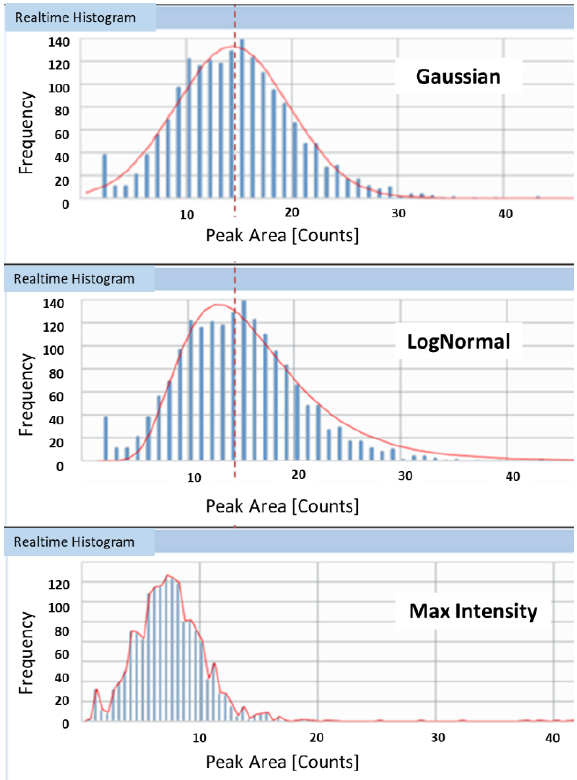
Figure 10. Impact of the choice of fitting model (red non-dashed line) on the mean intensity used for the determination of transport efficiency.